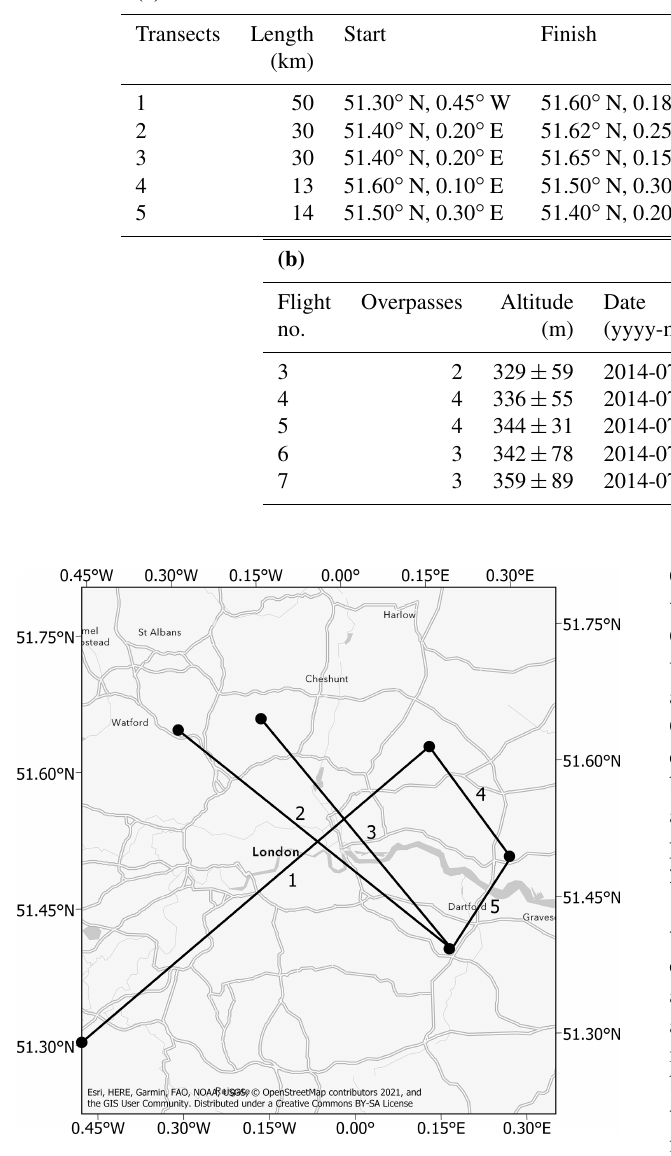
Figure 1. OPFUE 2014 flight path over Greater London, highlight- ing the incomplete figure-of-eight structure. Each transect type has been labelled. Plotted in ArcGIS ® (Esri,